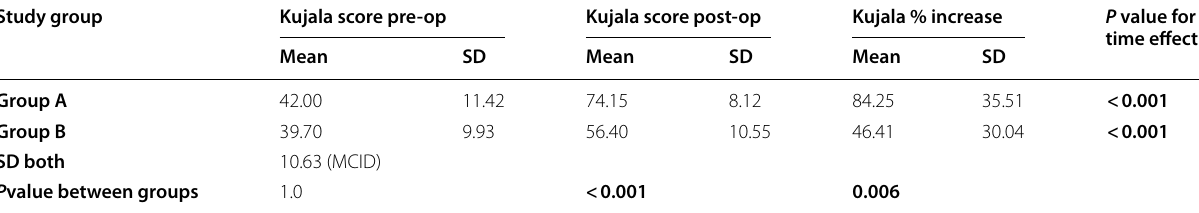
Table 4 Kujala score before treatment, after treatment with % difference from baseline in both groups Study group Kujala score pre‑op Kujala score